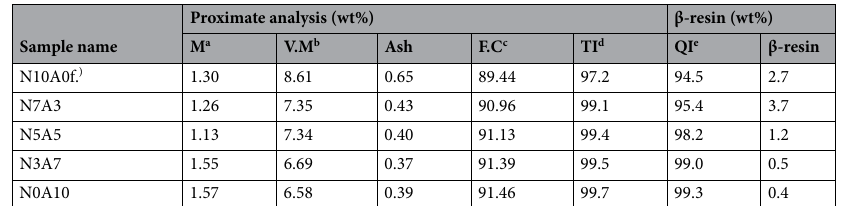
Table 1. Properties of binderless cokes manufactured according to the flow ratio of nitrogen and air. a Moistrue. b Volatile matter. c Fixed carbon. d Toluene insoluble. e Quinoline insoluble. f N